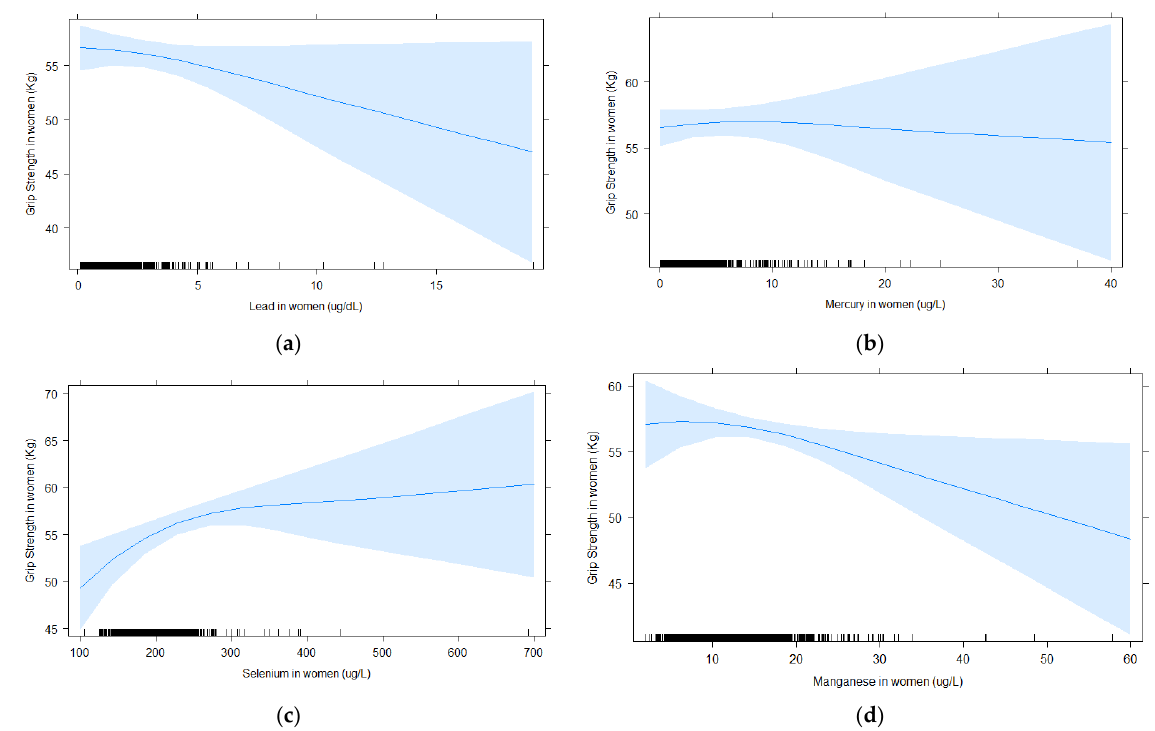
Figure 1. For women, associations between blood element concentrations and grip strength analyzed with splines (5 knots) for ( a ) lead, ( b ) mercury, ( c ) selenium, and ( d ) manganese. All models were adjusted for age, BMI, education, race/ethnicity, income to poverty ratio, smoking, and alcohol consumption.